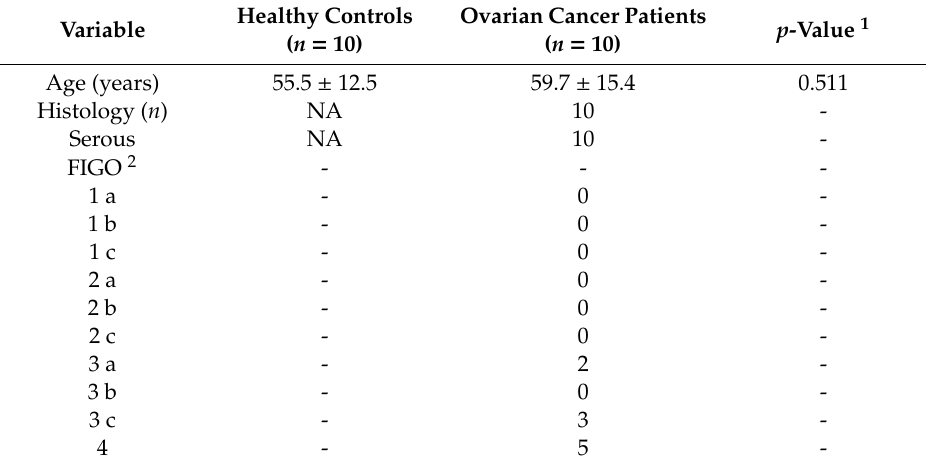
Table 1. Demographic and clinical variables of the clinical